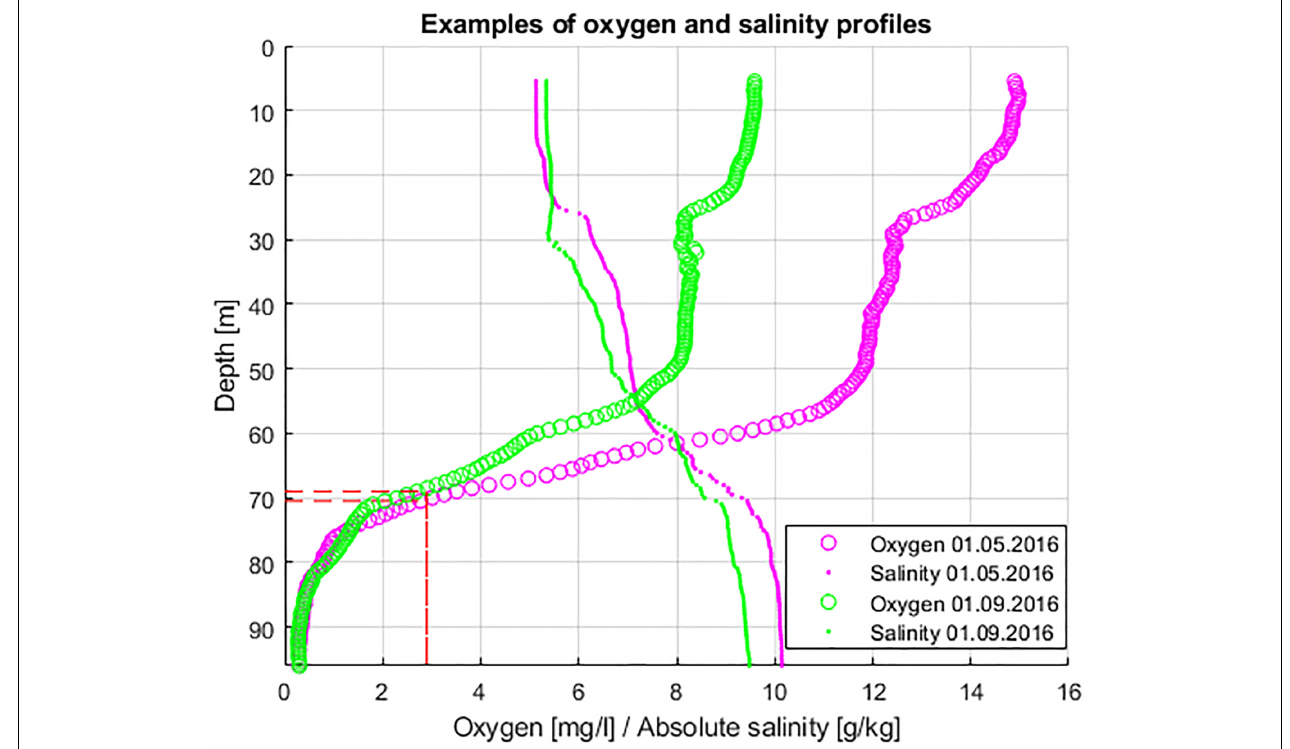
FIGURE 2 | Examples of oxygen and salinity profiles (magenta – 1st of May 2016, green – 1st of September 2016). The upper border of hypoxia (O 2 < = 2.9 mg · l − 1 ) is marked with the red dashed